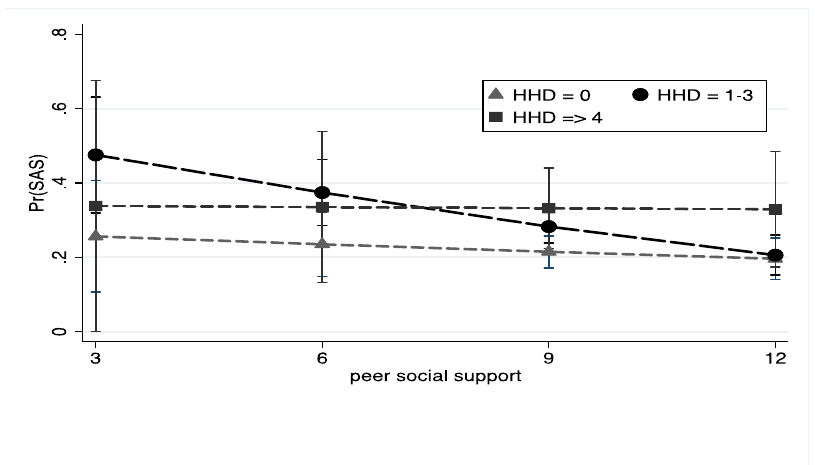
Figure 2. HHD, peer social support, and problematic smartphone use. Note: Figure depicts the predicted probability with 95% confidence intervals of problematic smartphone use among students with a history of HHD at low and high levels of social support. All models adjusted for age, gender, ethnicity, SES, COVID-19 employment loss, and depression.